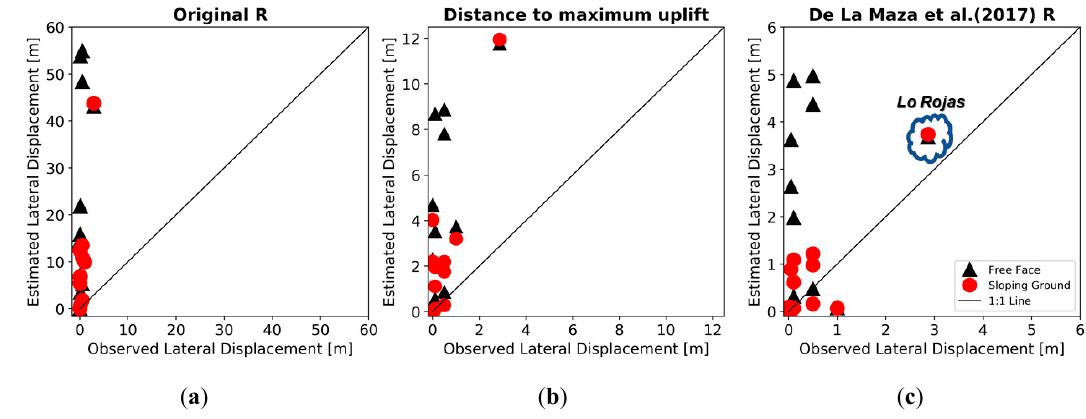
Figure 6. Observed versus estimated lateral displacements using: ( a ) original R-value from Youd et al.’s (2002) equation, ( b ) distance to the maximum uplift, and ( c ) distance adopted by De la Maza et al. (2017) [22].